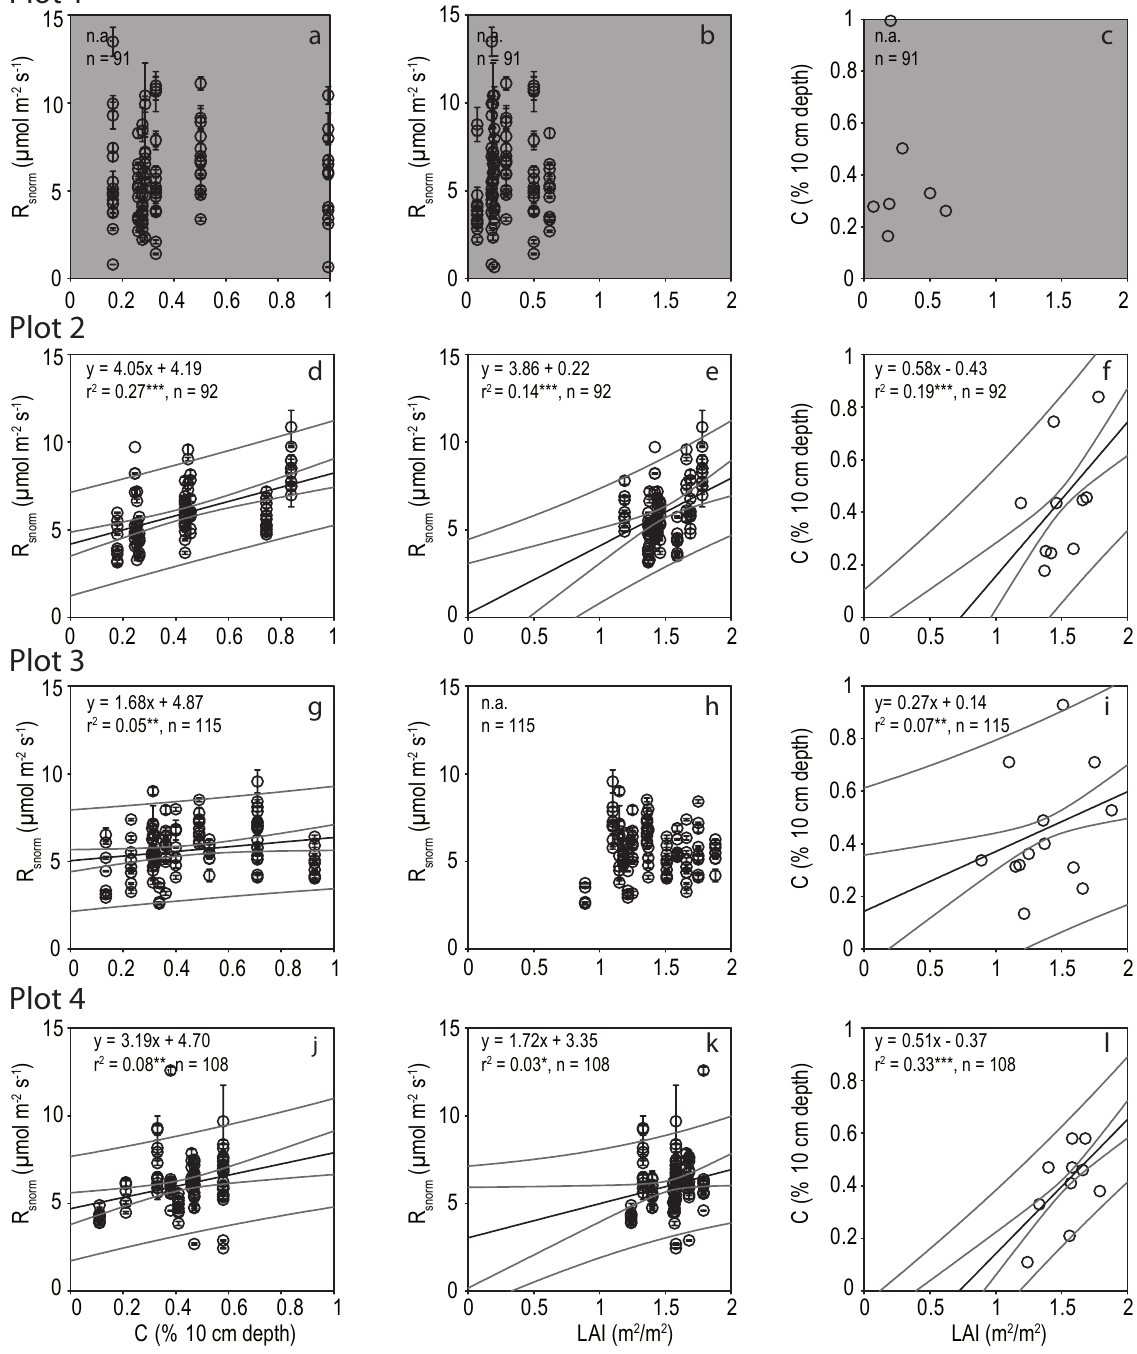
Fig. 6. The figure shows the relations between normalized soil respiration ( R snorm ) and soil carbon content (10cm depth) and leaf area index within each of the 4 inventory plots. Thick black lines represent the regression after applying a linear curve fit (statistics are given in Table 4). Thin black lines show the according 95 % confidence intervals and grey thin lines represent the 95 % prediction bands. No correlation was found for the disturbed plot 1. The last column shows the relation between belowground carbon content (10cm depth) and leaf area index,